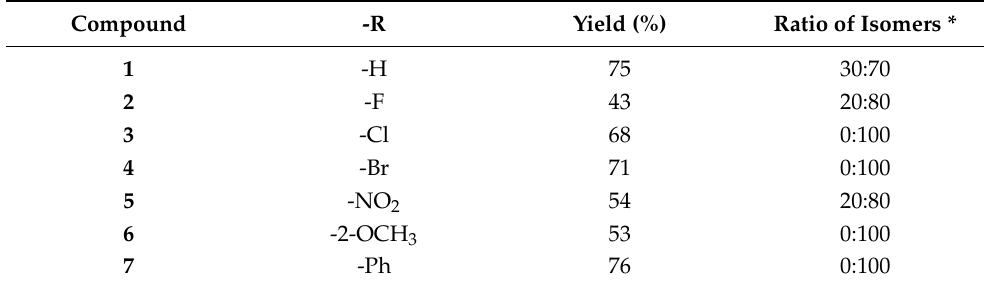
Table 1. Yield and ratio of the obtained isomers per compound.